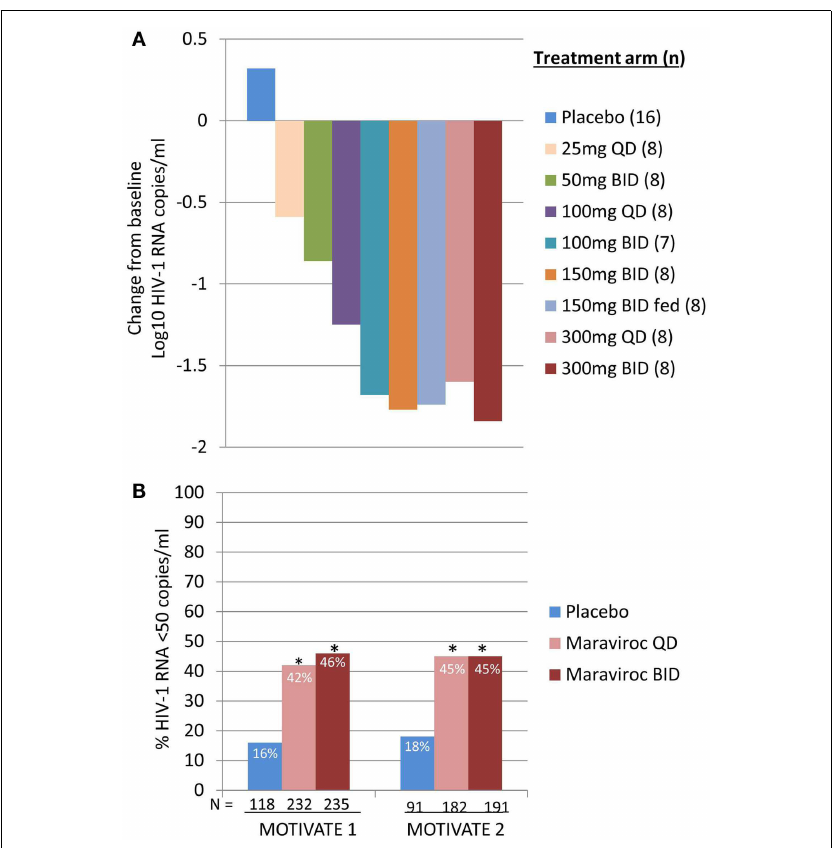
FIGURE 1 | Maraviroc proof of concept and phase 3 efficacy results . (A) Mean maximum change from baseline in HIV-1 RNA in patients receiving MVC monotherapy. Based on phase 1 data and modeling and simulation, doses ranging from 25mg QD to 300mg BID (including 150mg BID fed and fasted) were selected. HIV-1 RNA, safety, and MVC pharmacokinetics were evaluated (12). (B) MOTIVATE 1 and 2 – proportion of patients achieving HIV-1 RNA < 50 copies/mL at week 48. HIV-1 infected patients with R5 HIV-1 and triple class experience and/or resistance were randomized to receive MVC QD or BID, or placebo, in combination with an optimized background antiretroviral regimen (OBT). P < 0.001 (13,